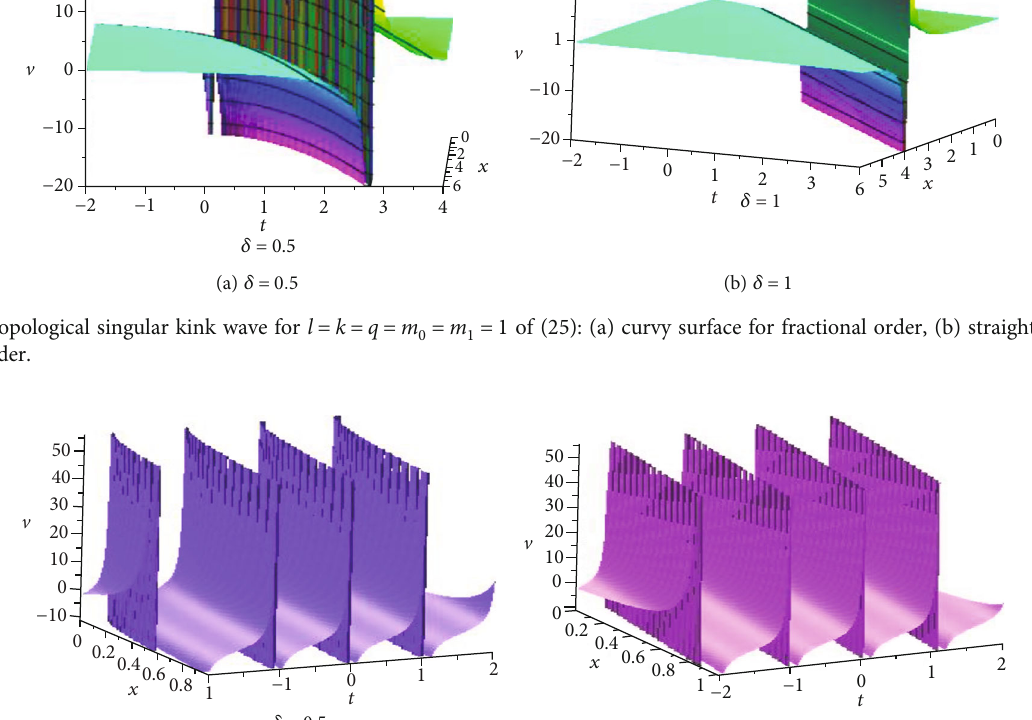
= 1, m = 2 , A = 1, l = 1 : 5, k = q = 1 of (26): (a) curvy surface for fractional order, (b) straight surface 1 0